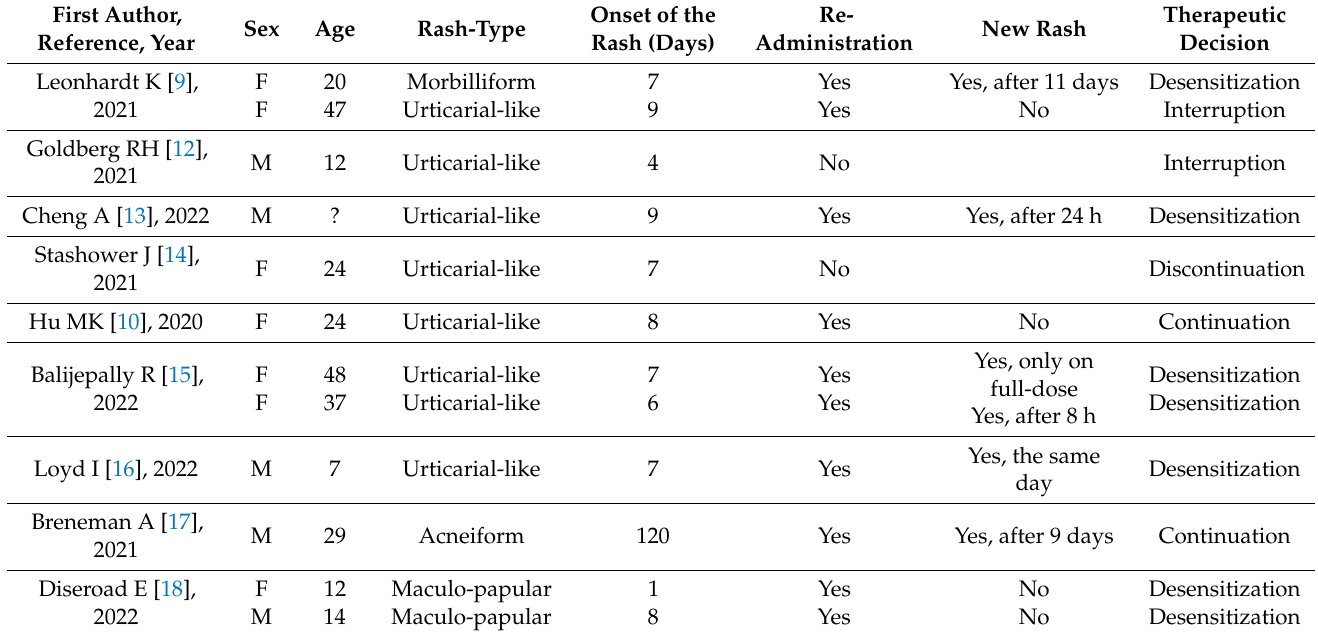
Table 1. Previous studies reporting cutaneous adverse reactions to